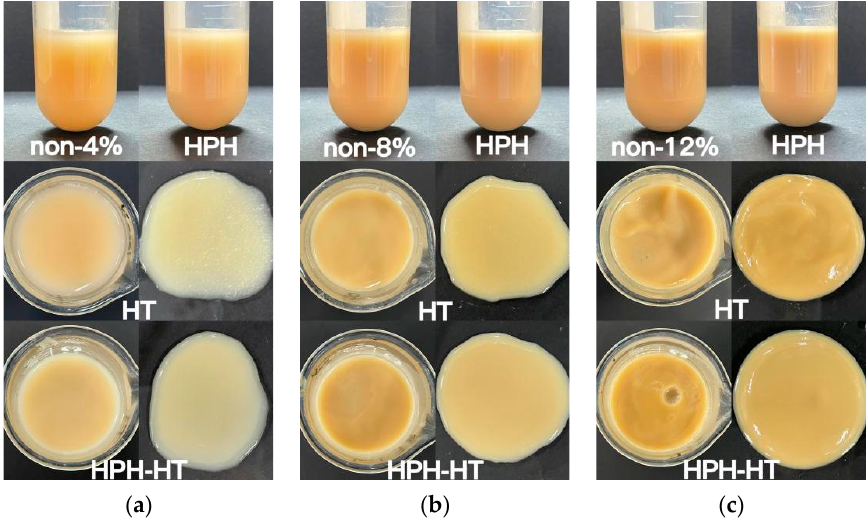
Figure 3. Appearance picture of DCF dispersion treated in different ways with the concentration of 4% ( a ), 8% ( b ), and 12% ( c ).